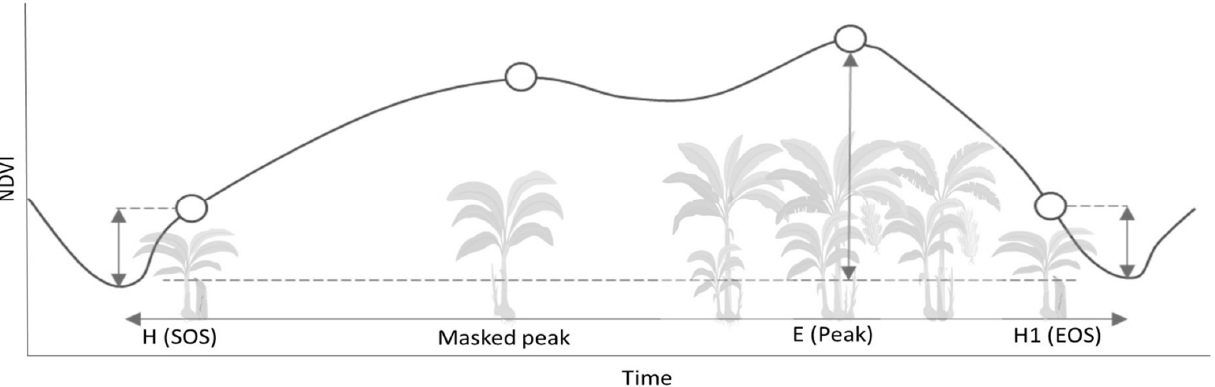
Figure 5. Threshold derivation as visualized for the banana plant bunch cycle using the normalised difference vegetation index (NDVI). Start of season (SOS) and end of season (EOS) are based on the seasonal amplitude setting; set as a percentage of amplitude from minimas on either side of the peak at which time harvesting of the mother plant and the onset of the follower plant vegetative stage (H and H1) occur. The peak of growth generally occurs at flower emergence (E) and should be indicated by a peak in time series data. Premature peaks in time series values are masked using minimum separation (horizontal arrow) and prominence of peak (vertical arrow) threshold settings.